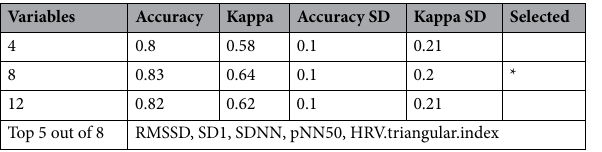
Table 4. Results of recursive features elimination algorithm applied to 12 prior knowledge-based selected HRV features.